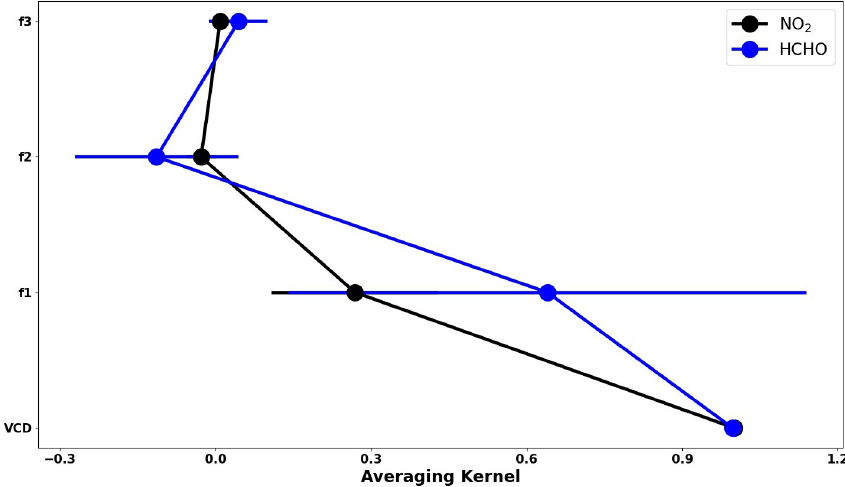
Figure 3. Mean averaging kernel of the NO 2 and HCHO retrievals from observations at Phimai during 2017. The error bars represent the 1 σ standard deviation of the mean values.